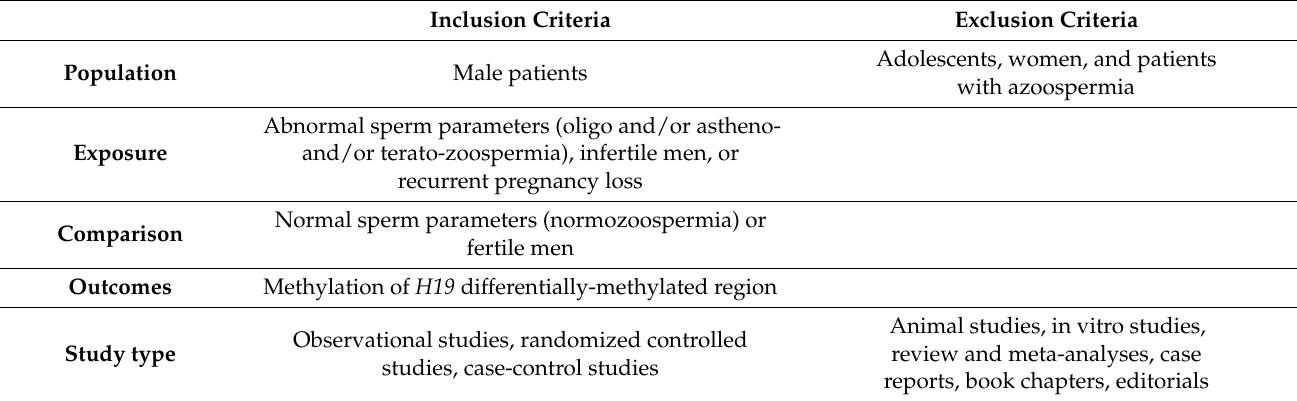
Table 1. Inclusion and exclusion criteria according to the PECOS model [18]. Inclusion Criteria Exclusion Criteria Adolescents, women, and patients Male patients with